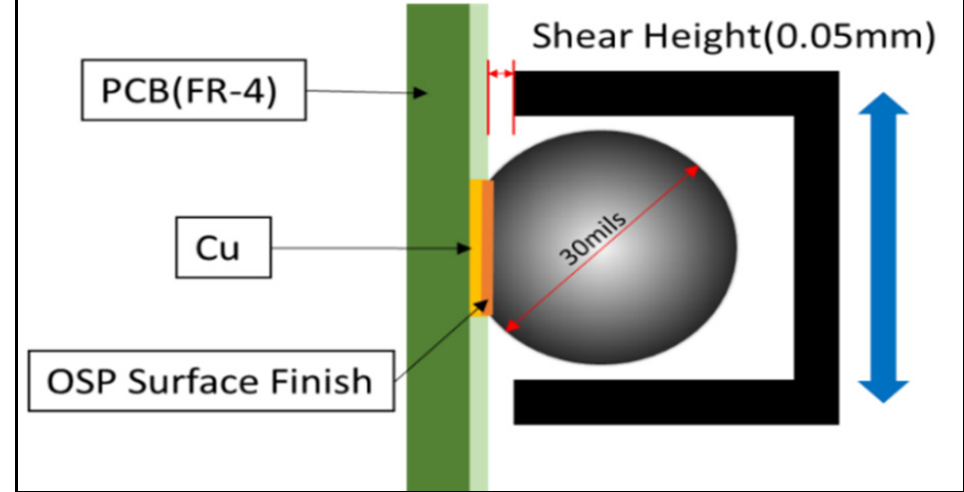
Figure 3. Cycling of solder joint.